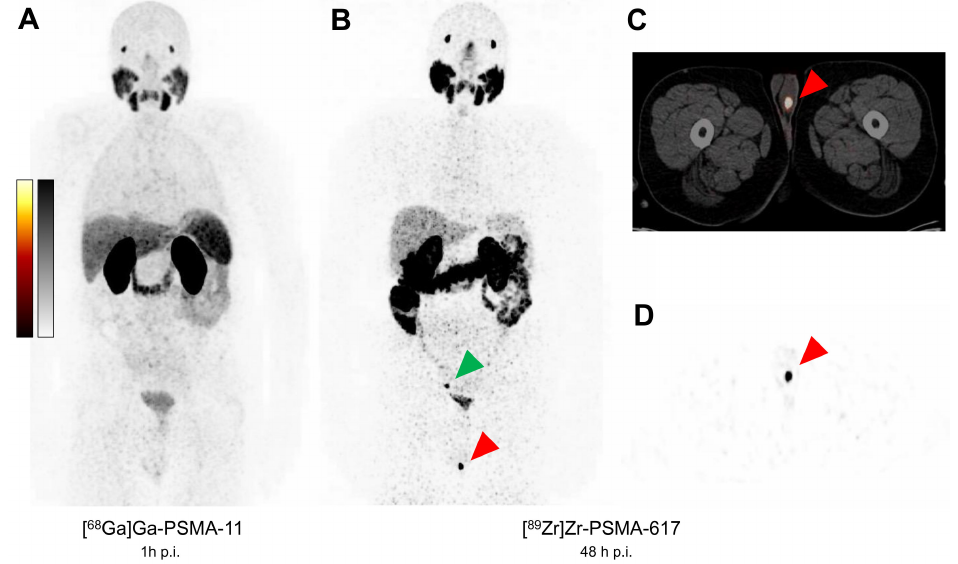
Figure 1. Molecular imaging. ( A ): MIP (maximum intensity projection) of [ 68 Ga]Ga-PSMA-11 PET/CT (167 MBq) 1 h post injection (p.i.) without suspicious findings. ( B ): MIP of [ 89 Zr]Zr-PSMA- 617 PET/CT (140 MBq) 48 h p.i. and transversal slices of ( C ): PET/CT fusion and ( D ): PET showing intense focal uptake (SUV max 33.1) in the left testis (red arrows) which was confirmed as testicular metastasis. Green arrow points to an intense focal uptake in the right pelvis (SUV max 27.8) suspicious for an iliac lymph node metastasis. Synthesis and quality control of [ 89 Zr]Zr-PSMA-617 followed published procedures [5,6]. PET/CT acquisitions were performed on a Biograph mCT 40 PET/CT scanner (Siemens Medical Solutions, Knoxville, TN, USA). The duration of PET acquisition was 3 min per bed position for 68 Ga 1 h p.i. and was extended to 5 min per bed position for 89 Zr 48 h p.i. PET images were reconstructed by applying an iterative 3D ordered-subset expectation maximization algorithm with 3 iterations and 24